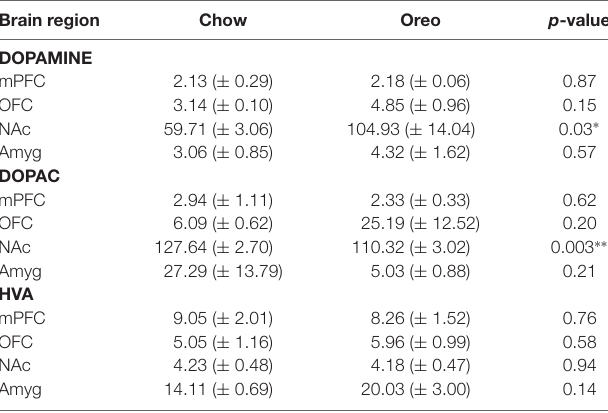
TABLE 1 | Effect of patterned feeding of HPF on dopamine, DOPAC, and HVA levels in the brain reward circuitry. Brain region Chow Oreo p -value DOPAMINE mPFC